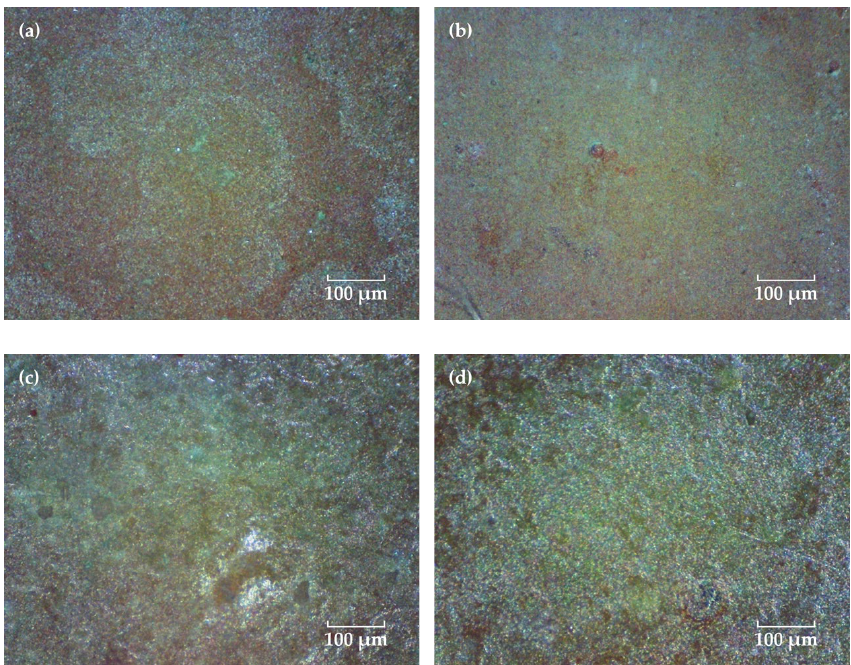
Figure 1. EIS spectra and surface photographs of the FW-1 coating sample in 160 d immersion test: ( a ) Nyquist plot; ( b ) Bode plot; ( c ) digital photos.